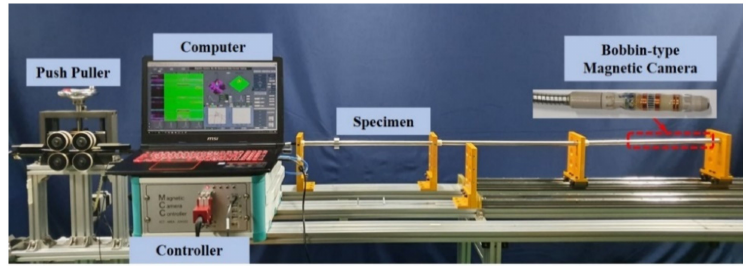
Figure 4. Experimental setup.